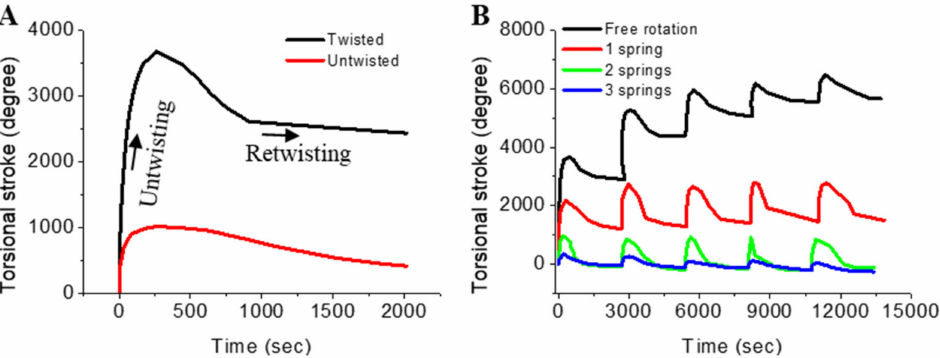
Figure 5. Torsional stroke results of gel/fibre actuators: ( A ) comparative stroke found from untwisted twisted fibres; ( B ) comparative stroke when the actuator was operated freely or against return